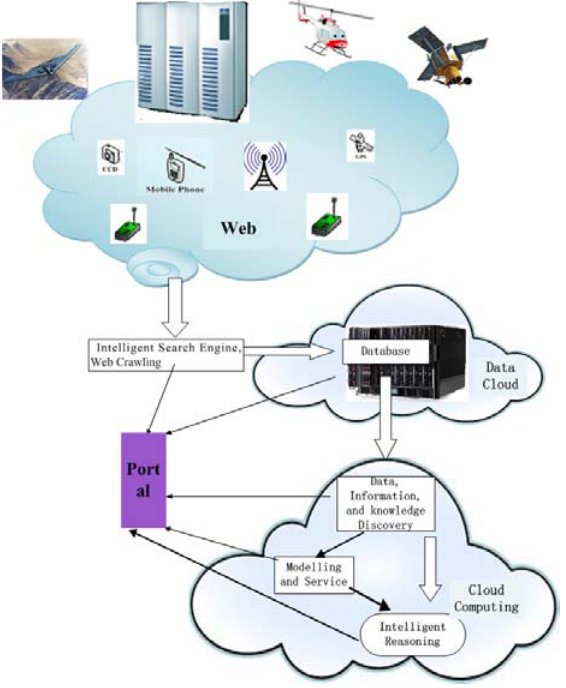
Figure 1. The concept of Web